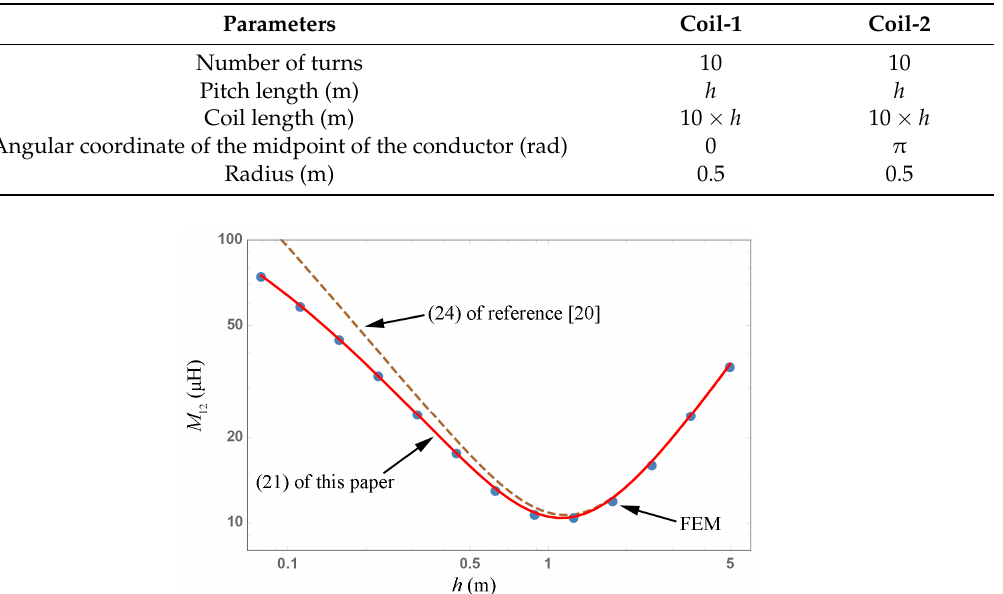
M ) of coils with equal radius. 12